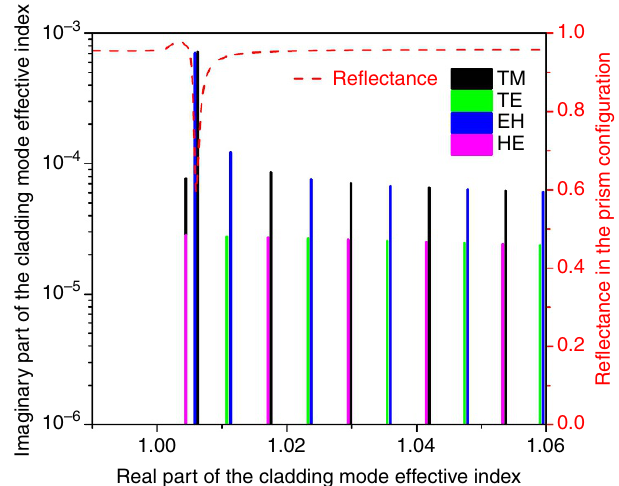
Figure 3 | Simulation of the attenuation of gold-coated fibre-cladding modes with effective indices near 1.0. Each vertical bar corresponds to a particular cladding mode and is colour-coded by its polarization state (TM and EH, which are P-polarized at the cladding surface; TE and HE, which are S-polarized). The dashed red line shows the theoretical reflectance of a conventional prism-based SPR device made from the same materials as the fibre (silica with a refractive index of 1.445), as a function of the effective refractive index of a TM surface wave propagating along the base of the prism during total internal reflection. A pair of P-polarized cladding modes with an effective index near 1.007 is phase-matched to an SPP and has an attenuation that is larger than that of its neighbours by one order of